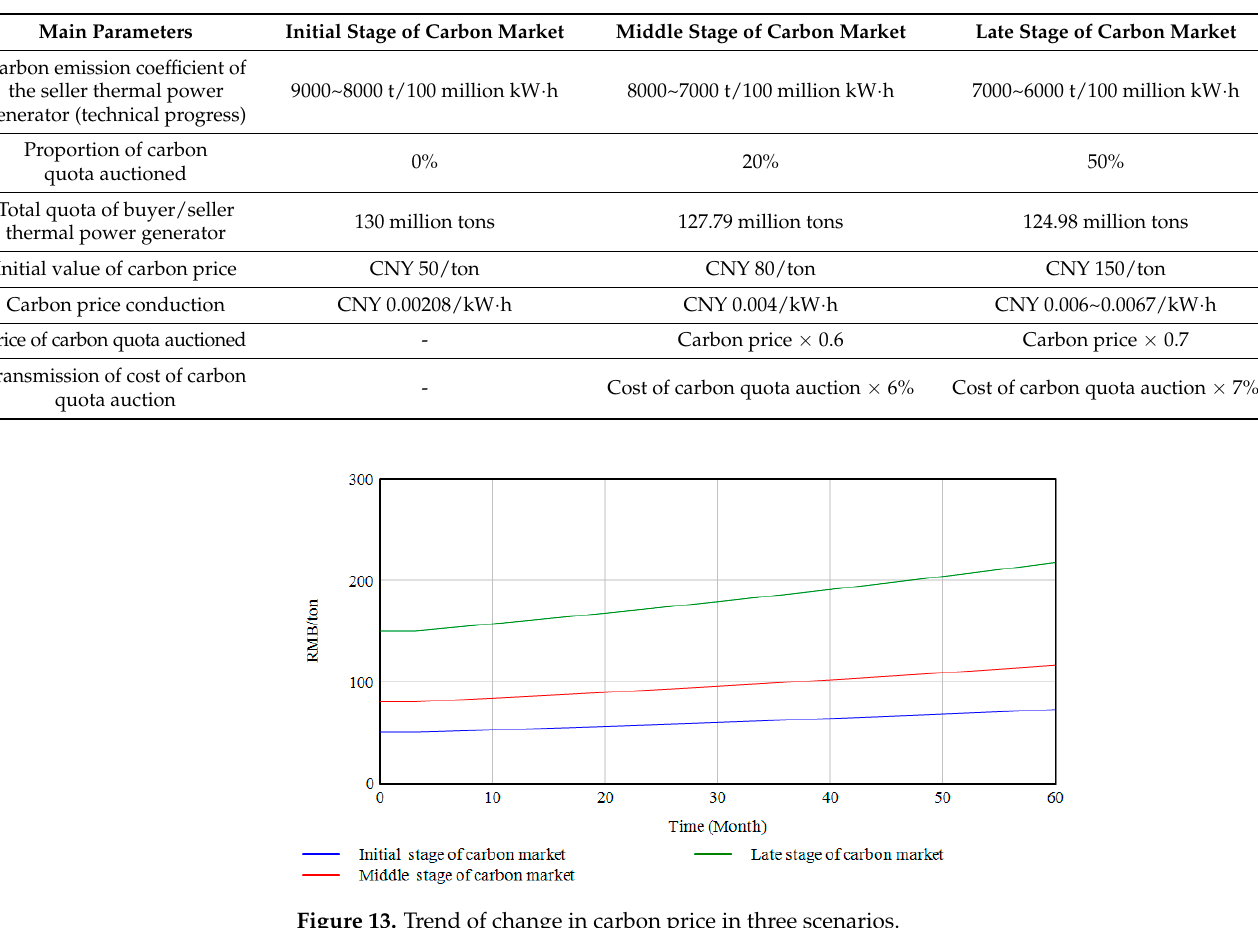
Table 2. Multi-scenario settings.